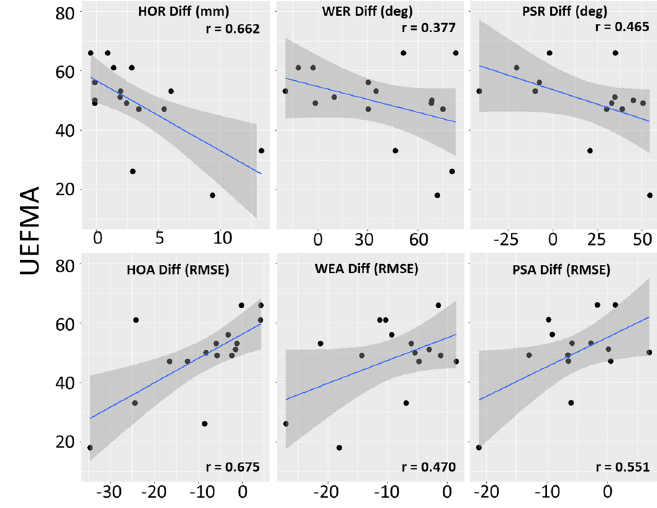
Figure 5. Correlations between Differences in Impaired and Unimpaired Hand LMC measures and Upper extremity Fugl-Meyer Assessment.